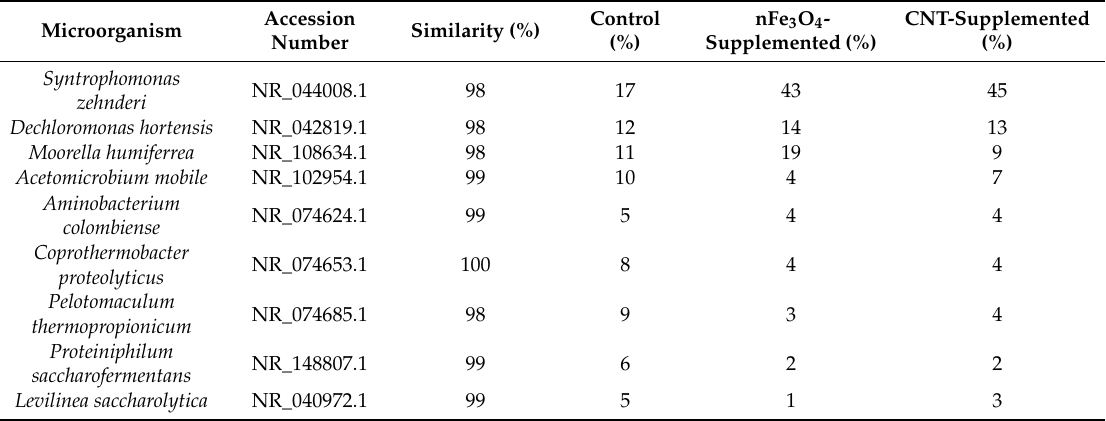
Table 3. Bacterial communities in species level identification of the dominant sequences of control, nFe 3 O 4 -supplemented, and CNT-supplemented